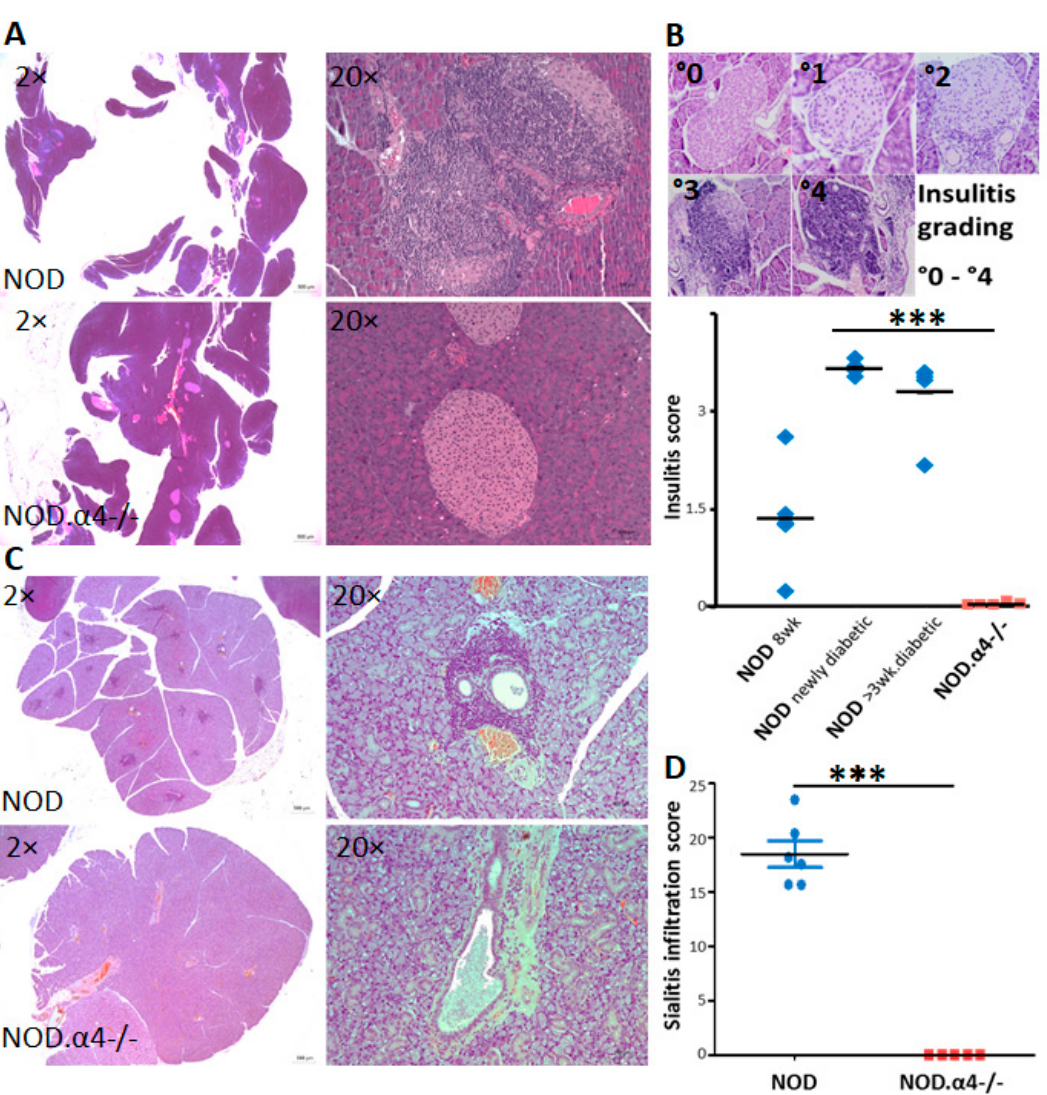
Figure 2. Histological analysis of pancreas islets and submandibular glands. Histological evaluation of lymphocyte infiltration of pancreas islets ( A , B ) and submandibular glands ( C , D ). Exemplary appearance of diabetic NOD or age-matched NOD. α 4-/- pancreas ( A ) and quantitative analysis of insulitis severity in the indicated groups ( B ). Each dot represents the average insulitis score from multiple non-consecutive sections from one animal, the bar marking the mean (n = 5 (NOD) to 8 (NOD. α 4-/-) animals per group; p < 0.005 for NOD. α 4-/- vs. each of the NOD groups, p = n.s. between NOD groups). Inset images of islets in ( B ) exemplify the 5-grade histological scoring system between 0 and 4. Exemplary appearance of NOD or NOD. α 4-/- submandibular glands ( C ) and enumeration of sialitis score ( D ). Each dot represents the average sialitis score from multiple non-consecutive sections from one animal, the bar marking the mean ( n = 5–6 animals per group; p < 0.001). Asterisks indicate statistical significance at the 0.005 (***) level.